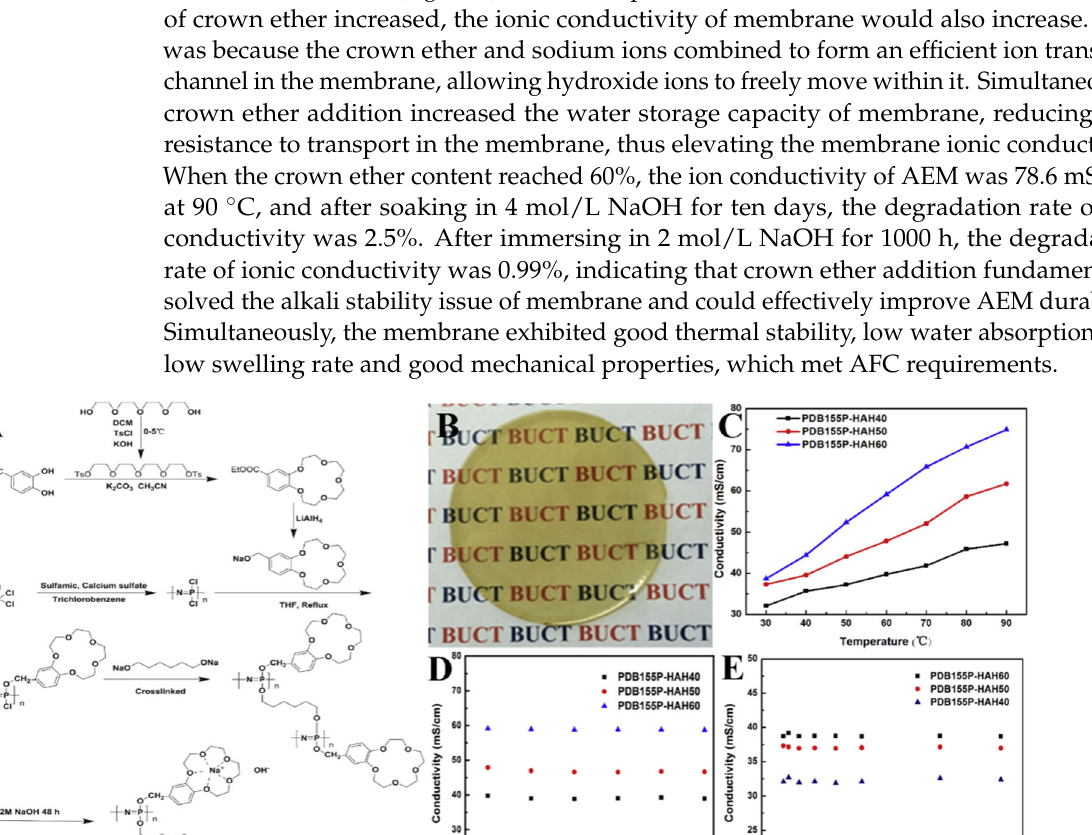
Figure 6. ( A ) The scheme of membrane fabrication. ( B ) TEM image of membrane with LDH under an AC electric field. ( C ) AEMs ionic conductivity as a temperature function. ( D ) The schematic dia ‐ gram of electric field − introduced orientation of LDH nano–platelets in a heterogeneous solution. Taken with permission from [126].